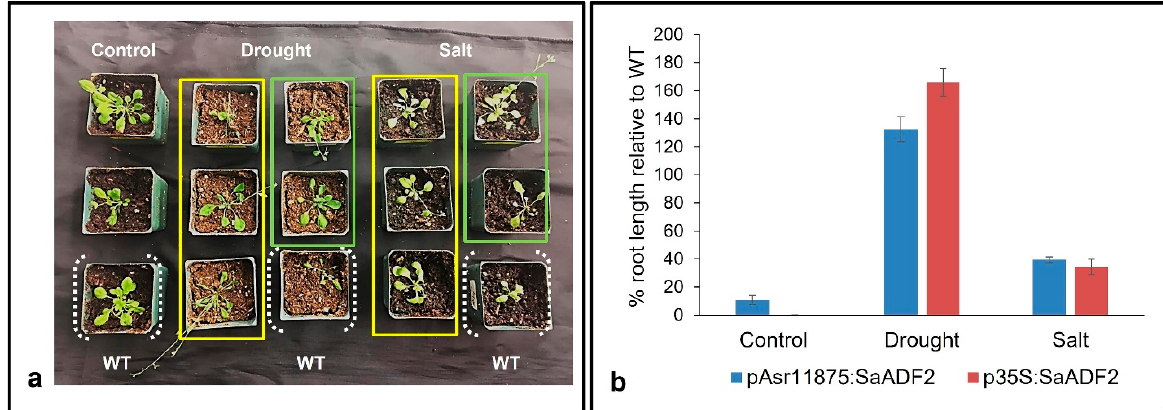
Figure 4. Phenotype ( a ) and percentage increase of root length relative to wild-type (WT) ( b ) of Arabidopsis mutants overexpressing SaADF2 gene under pAsr11875 (within the yellow rectangle) and constitutive p35S promoter (within the light green rectangle) after 1 week of exposure to drought stress and salt (150 mM NaCl) stress.